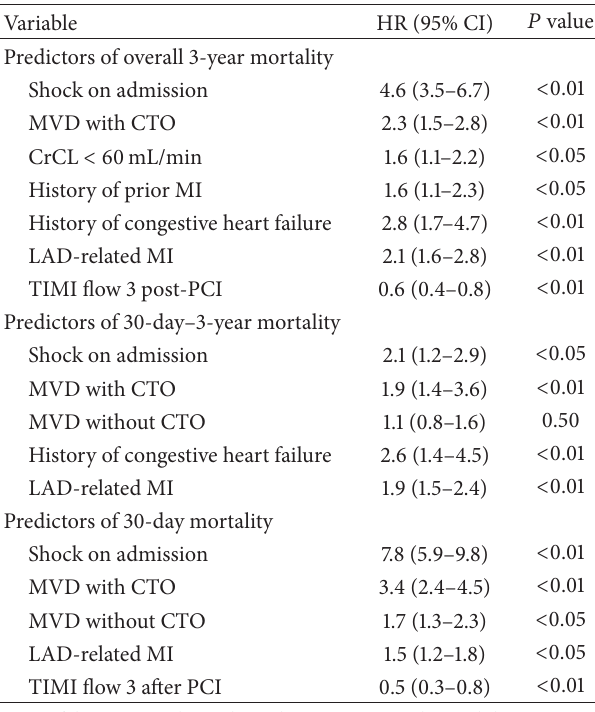
Table 5: Independent predictors of early (0–30 days) and late (30 days–3 years)